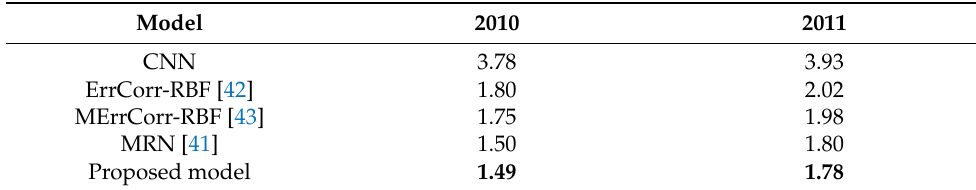
Table 4. Performance comparison of MAPEs on the data of New England dataset during 2010 and 2011.